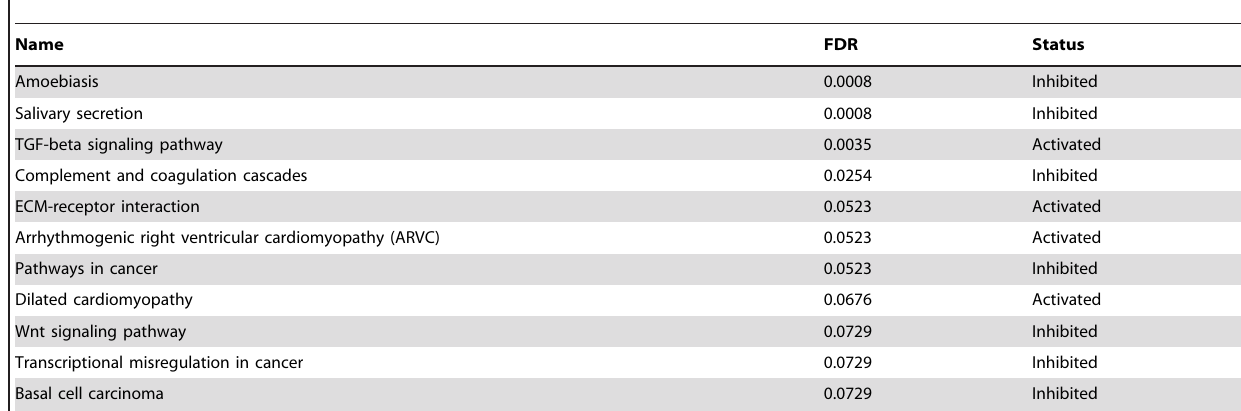
Table 5. SPIA results when provided with DE genes significant at 10%